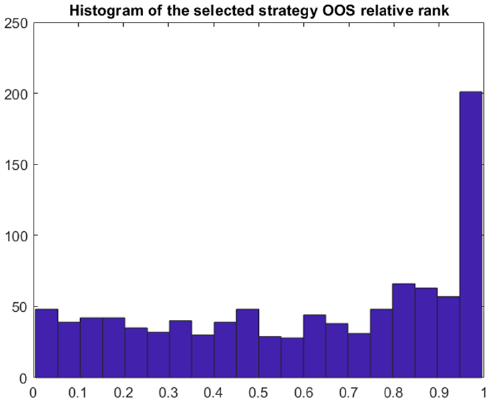
Figure 14. Bayes model 2 simulation of the ex ante (blue) and ex post (red) probability densities.